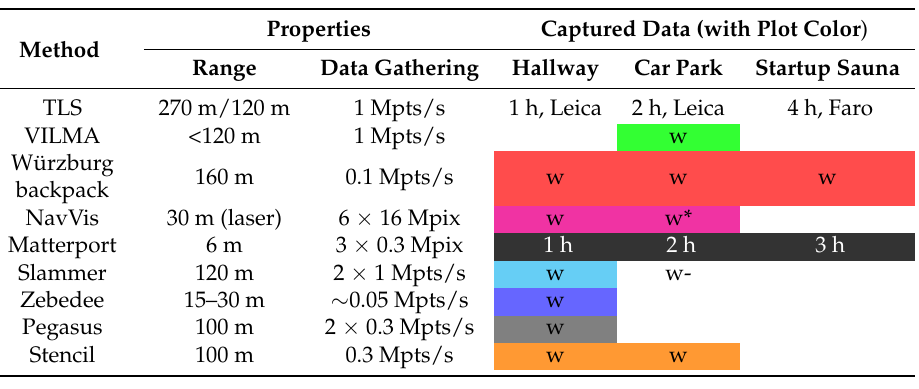
Table 1. Data capture numerics for this study from the three test sites. Gathering was planned to yield sufficiently different data to study the metrics. Abbreviation w stands for mobile methods that are used at smooth walking speed, roughly 2 min for the hallway, 10 min for the car park and 4 min for the Startup Sauna. See the text for w* and